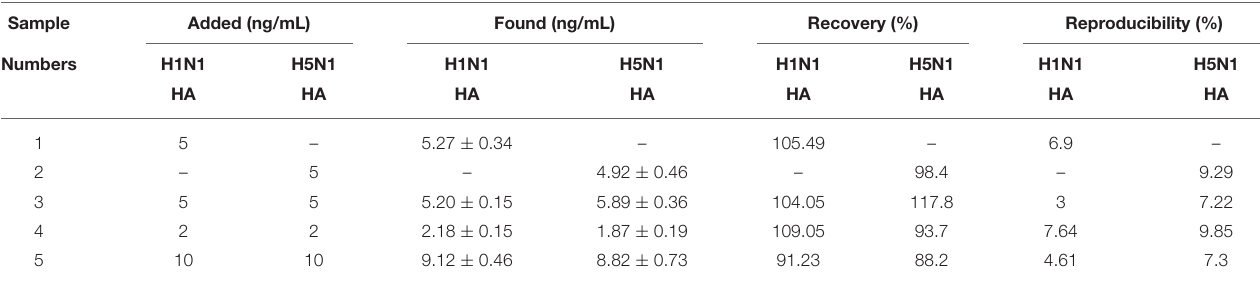
TABLE 2 | Dual detection of the HA from H1N1 and H5N1 viruses in human serum samples.